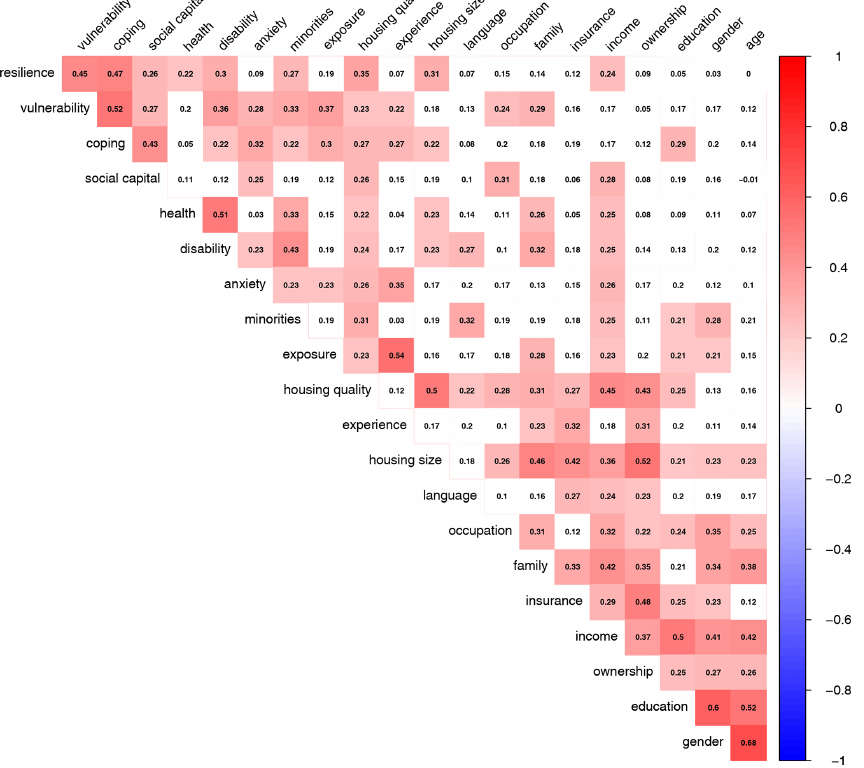
Nat. Hazards Earth Syst. Sci., 22, 2655–2672, 2022